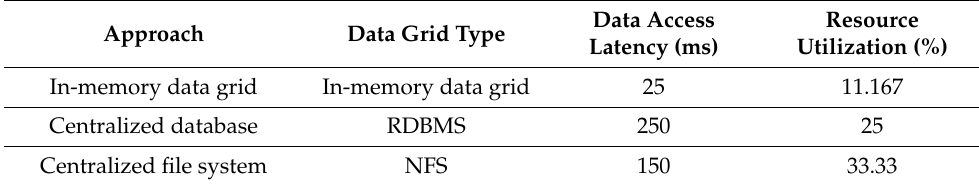
Table 9. Experimental results for replication tasks.